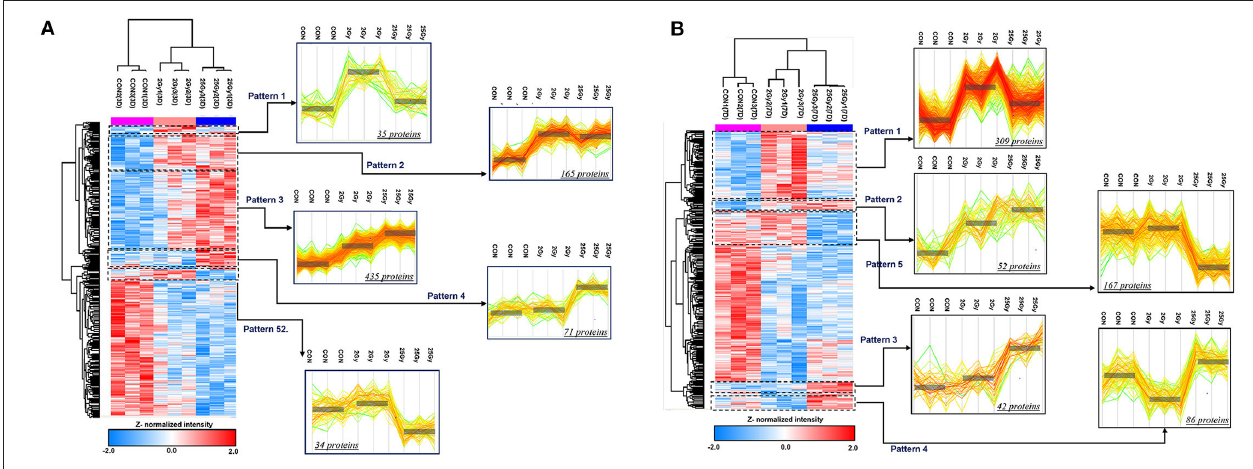
FIGURE 3 | ANOVA pattern clustering analysis of differentially expressed proteins related to dose group in irradiated rat. The hierarchical cluster was performed after ANOVA multiple comparison test between 0, 2, and 25Gy at day 3 and day 7, respectively. The pre-process was implemented by unbiased K-means clustering. Among the defined clusters, we subdivide those to investigate the detailed pattern of proteome alterations related to dose of irradiation. The colorimetric scheme represented z-normalized intensity of DEPs. (A) Defined clusters that reveals specific expression pattern of DEPs at day 3 ( P -value < 0.05, 1,489 proteins). The clusters were divided with 2.245 threshold. The detailed clusters show the protein alteration patterns with specifically up-regulated in 2Gy irradiation (pattern 1), gradually increasing according to increasing dose of irradiation (pattern 2 and 3), specifically up-regulated (pattern 4), and down-regulated in 25Gy irradiation (pattern 5). (B) Defined clusters that reveals specific expression pattern of DEPs at day 7 ( P -value < 0.05, 1,283 proteins). The clusters were divided with 2.476 threshold. The detailed clusters show the protein alteration patterns with specifically up-regulated in 2Gy irradiation (pattern 1), gradually increasing according to increasing dose of irradiation (pattern 2 and 3), specifically up-regulated (pattern 4), and down-regulated in 25Gy irradiation (pattern